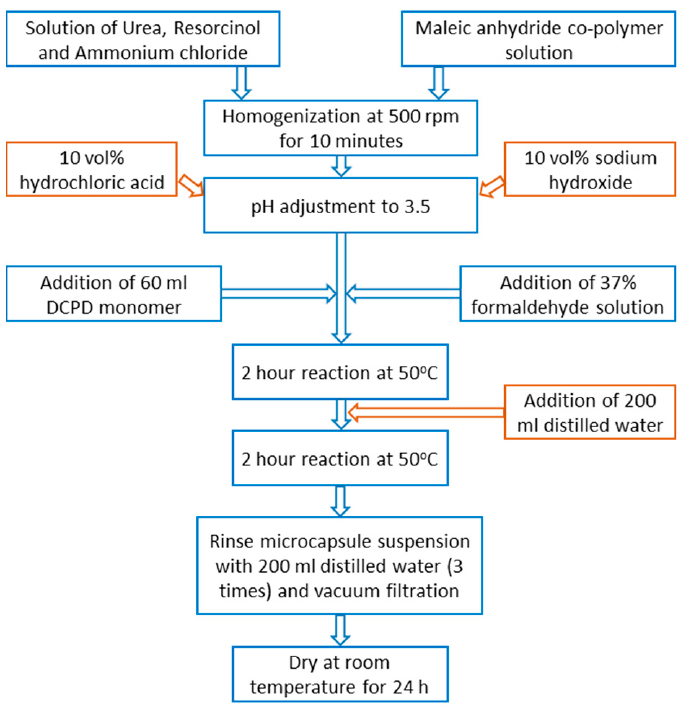
Figure 3. Process of PUF-DCPD microcapsule synthesis.